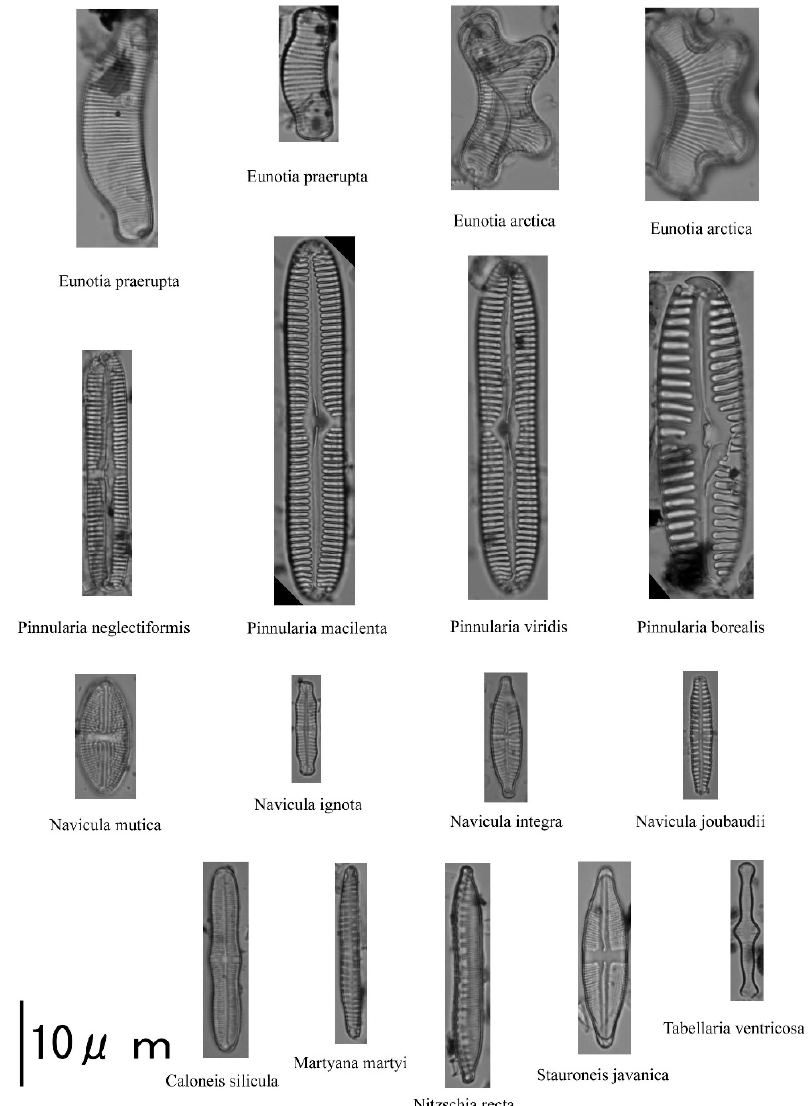
Figure 5. The dominant species of the diatom assemblages in 50 cm depth for the core TE08 in the Terelj River basin.